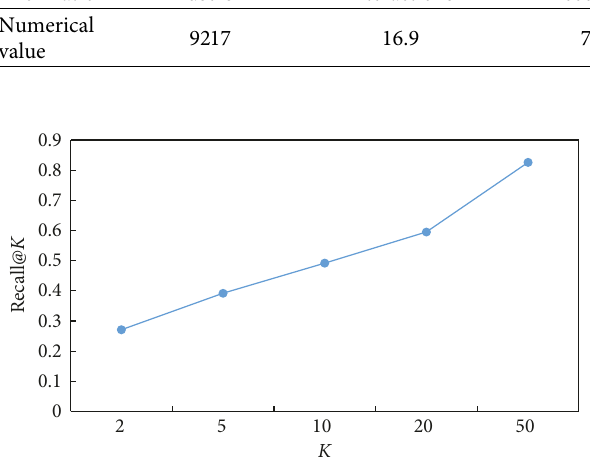
Figure 7: Recall results of top- K recommendation.